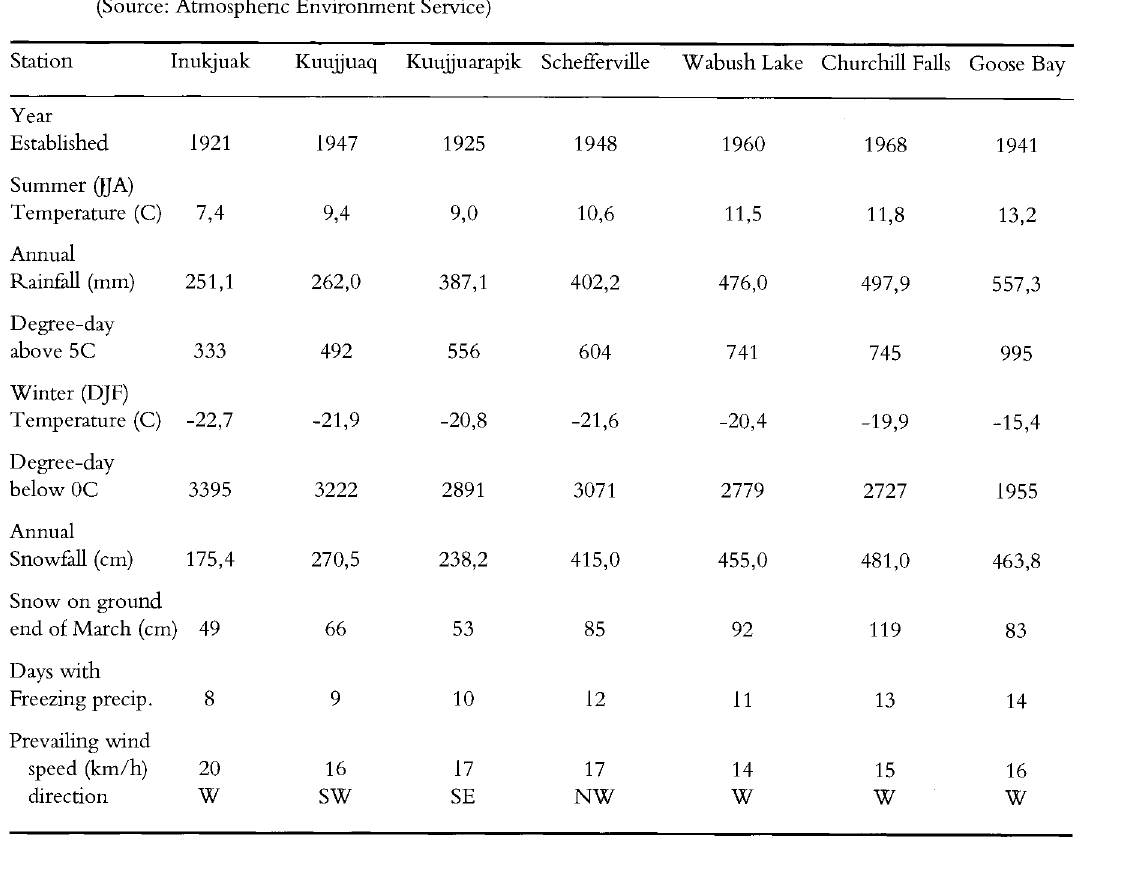
Table 1. Permanent Stations used in this study, with 1951- 1990 mean values for selected variables. (Source: Atmospheric Environment